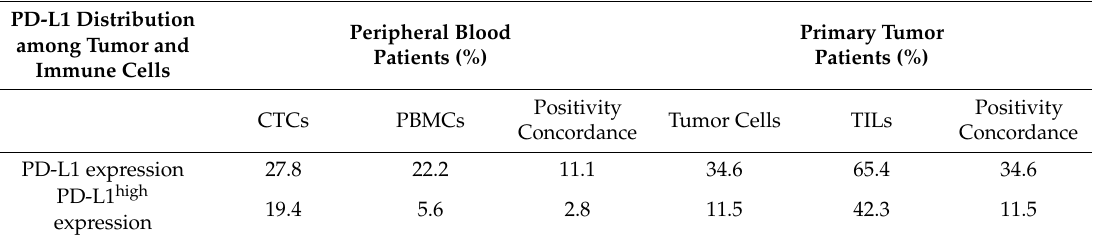
Table 5. Comparison of the PD-L1 status between tumor cells and immune cells within peripheral blood and primary